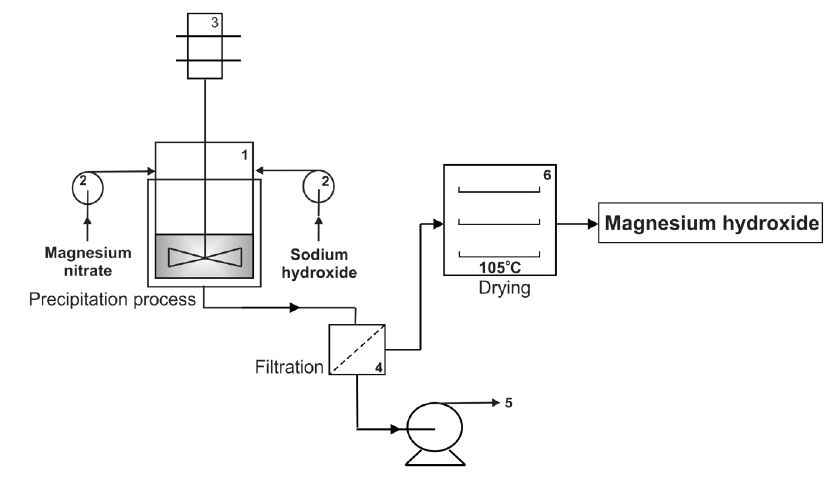
Figure 1: Magnesium hydroxide preparation. 1 – reactor; 2 – peristaltic pump; 3 – stirrer; 4 – pressure filter; 5 – vacuum pump; 6 –